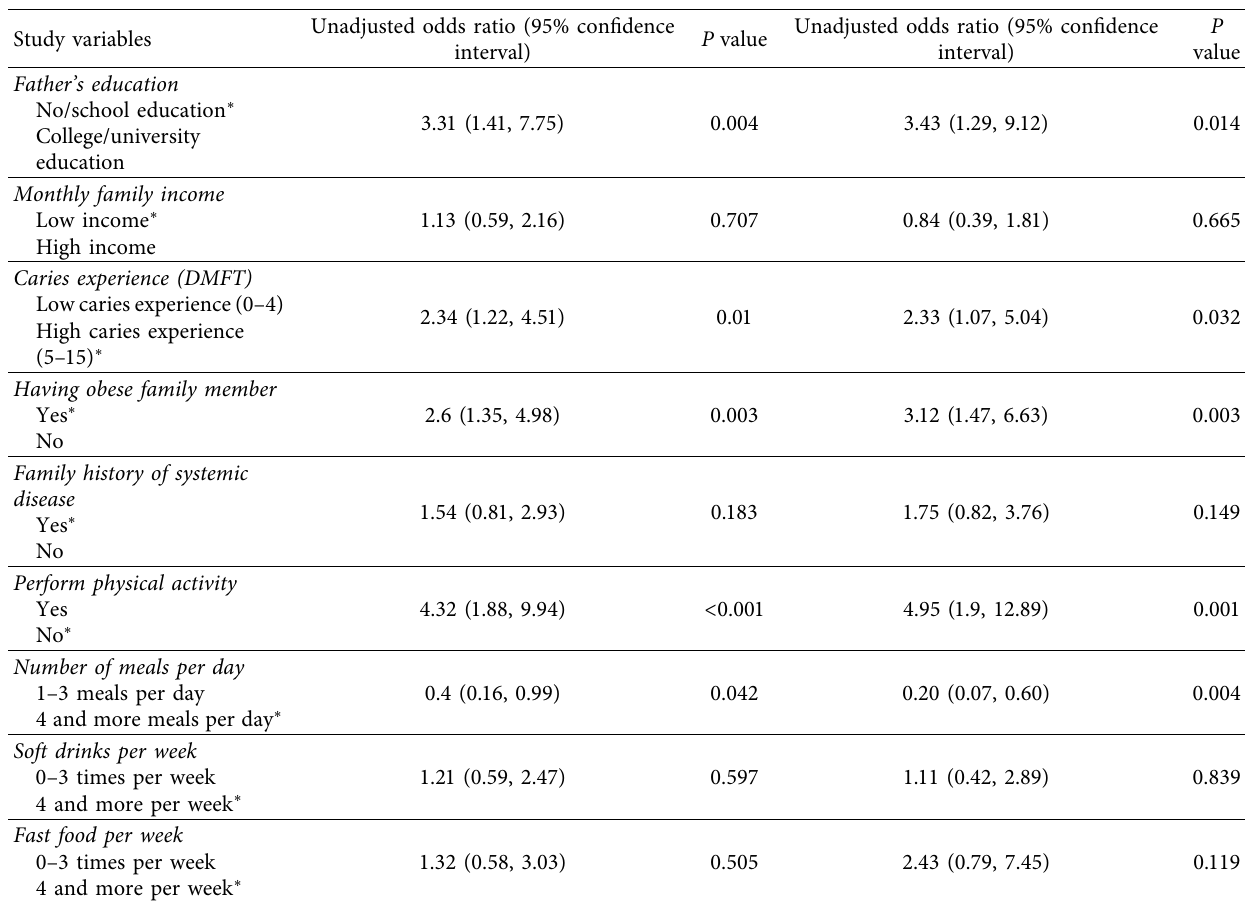
Table 3: Association of caries experience and other factors with obesity in study participants.